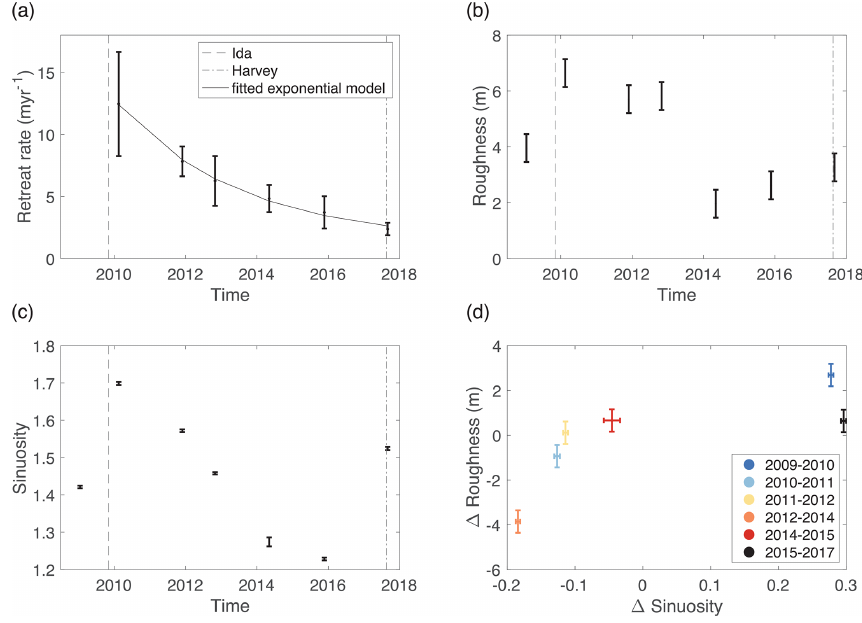
Figure 6. (a) Mean cliff retreat rate (myr − 1 ) through time. (b) Mean cliff roughness (m) through time. (c) Cliff sinuosity through time. (d) Change in cliff sinuosity vs. change in mean cliff roughness. Error bars represent propagated error.